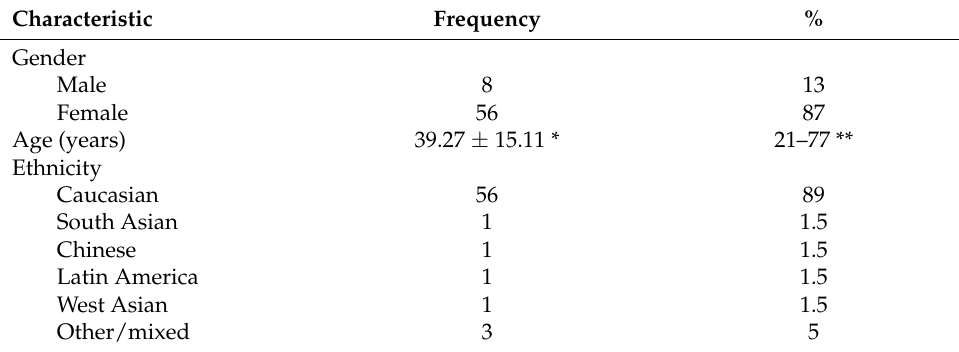
Table 1. Participant demographics ( n =